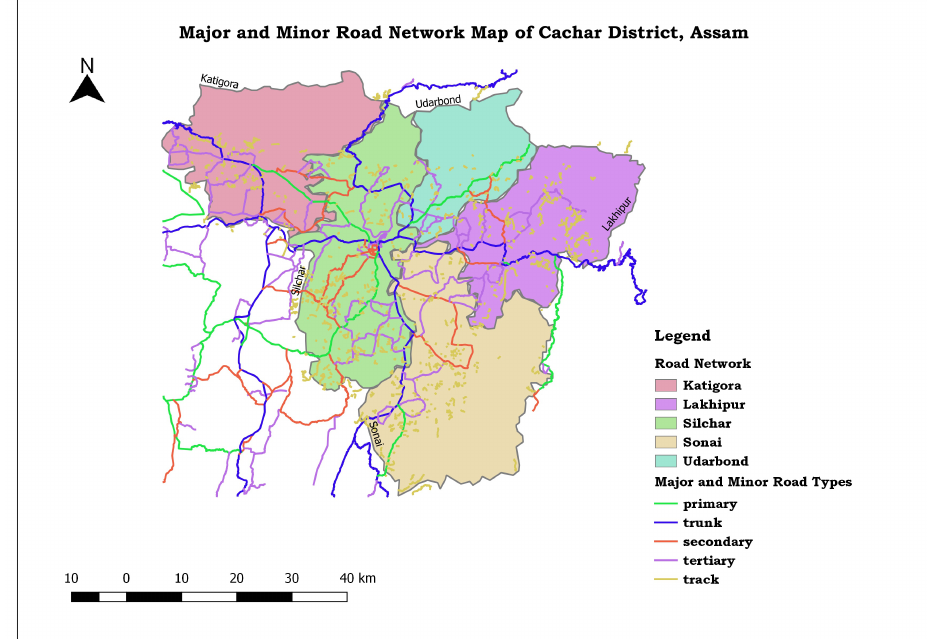
Figure 4. Major and minor roads in Cachar